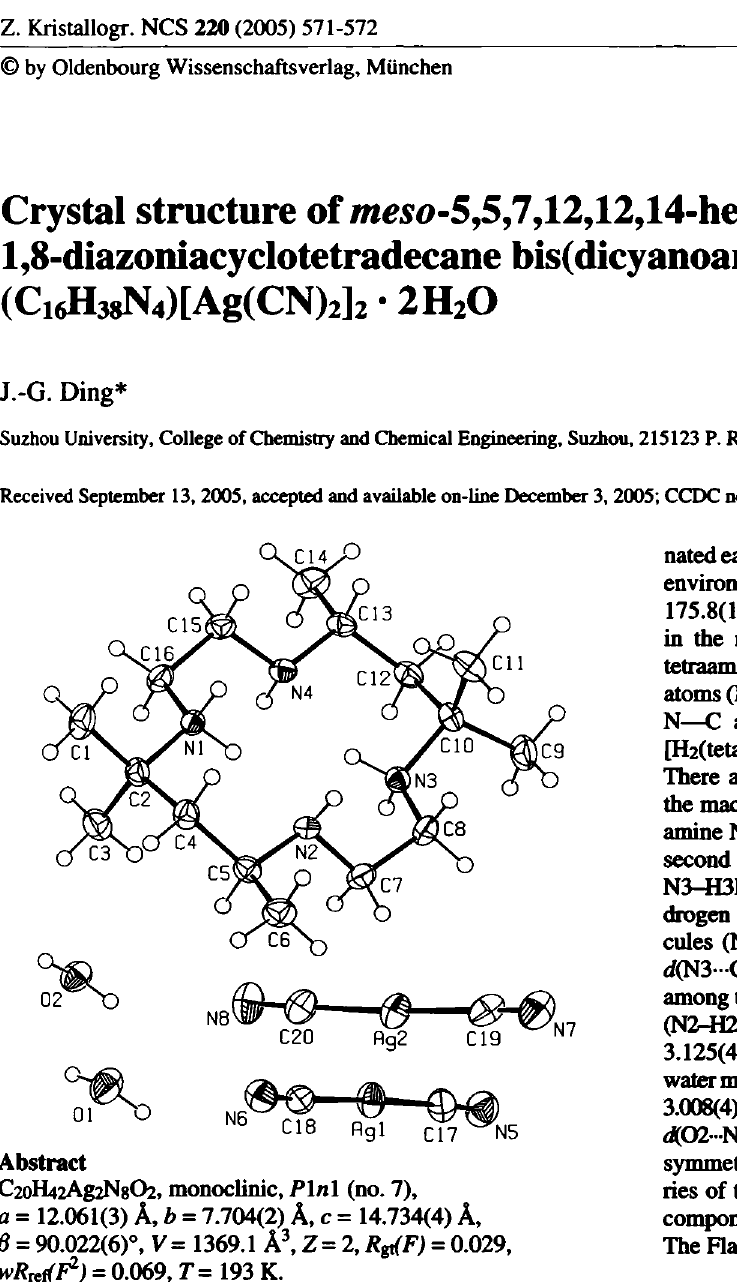
Table 1. Data collection and handling.